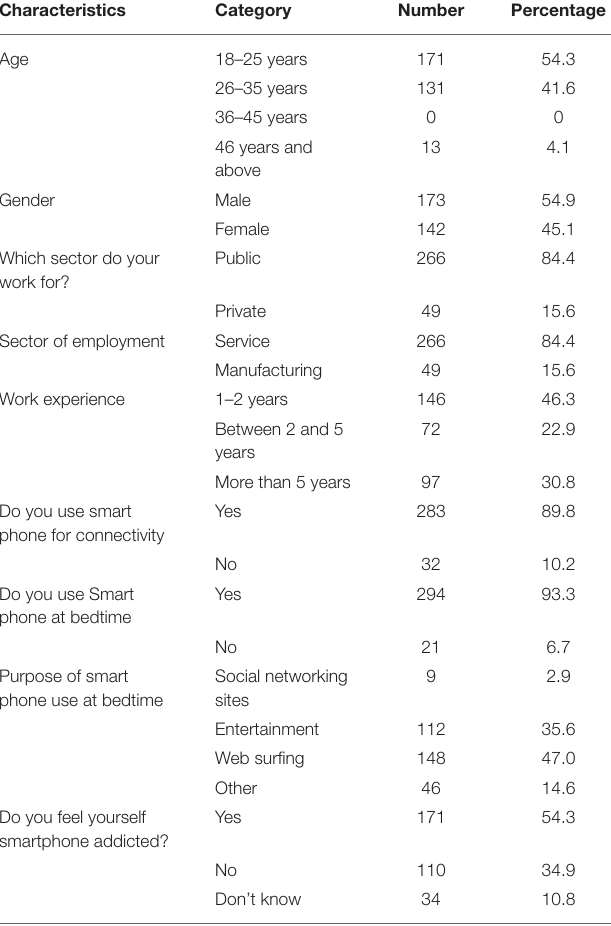
TABLE 1 | Survey participants’